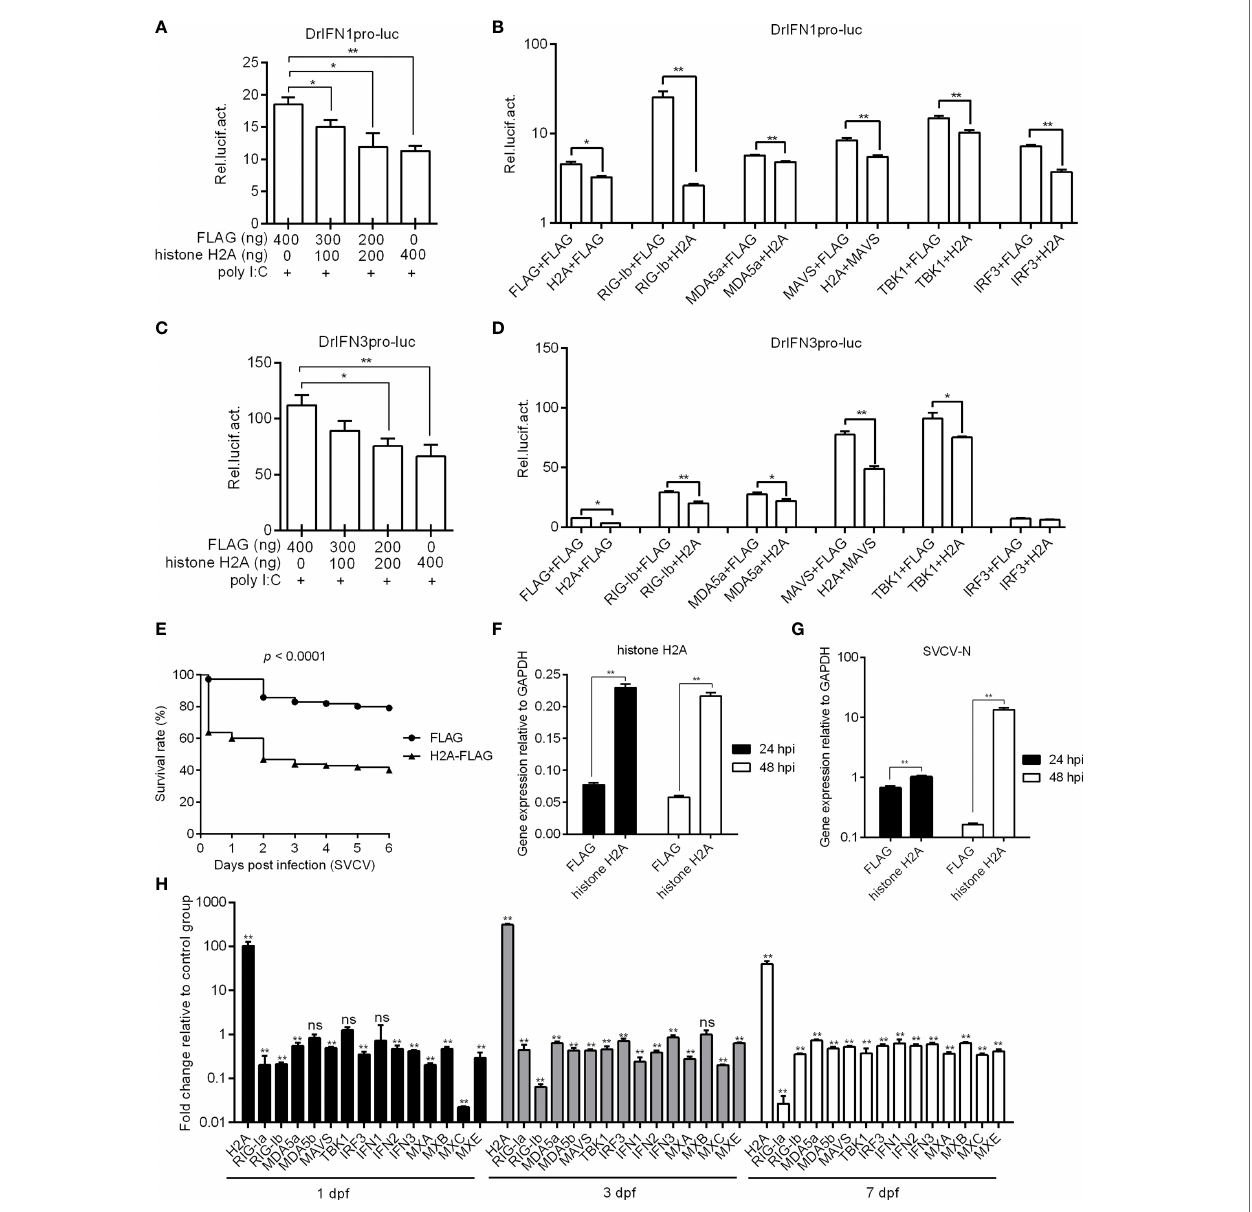
FIGURE 2 | Zebra fi sh histone H2A negatively regulates RLR signaling. (A) Effect of zebra fi sh histone H2A on the IFN1 promoter activity mediated by poly I:C stimulation. (B) Effect of zebra fi sh histone H2A on the IFN1 promoter activity mediated by RLR signaling pathway. (C) Effect of zebra fi sh histone H2A on the IFN3 promoter activity mediated by poly I:C stimulation. (D) Effect of zebra fi sh histone H2A on the IFN3 promoter activity mediated by RLR signaling pathway. For (A, C) , EPC cells transfected with various indicated plasmids and DNA concentration were stimulation with poly I:C. Another 24 h later, the cells were lysed and used for luciferase activity assay. For (B, D) , EPC cells were transfected with the indicated combination. At 48 h post-transfection, the cells were used for luciferase activity assay. (E) Effect of zebra fi sh histone H2A on the larvae survival. (F) The con fi rmation of zebra fi sh histone H2A expression in the histone H2A-overexpressed larvae with SVCV infection. (G) Effect of zebra fi sh histone H2A on the expression of SVCV-N gene. For (E – G) , zebra fi sh larvae microinjected with p3×FLAG or H2A-FLAG were infected with 2×10 6 PFU/mL SVCV for 24 h. For (E) , larvae were monitored for 6 days. For (F, G) , larvae were collected at 24 and 48 hpi, and used for qRT- PCR. (H) Effect of zebra fi sh histone H2A on the expression of antiviral genes involved in RLR signaling pathway. Zebra fi sh larvae microinjected with p3×FLAG or H2A-FLAG were collected at 1, 3 and 7 dpf, and used for qRT-PCR. For (A – D, F – H) , data represented means ± SEM (n = 3), and were tested for statistical signi fi cance. * p < 0.05; ** p < 0.01; ns, not signi fi